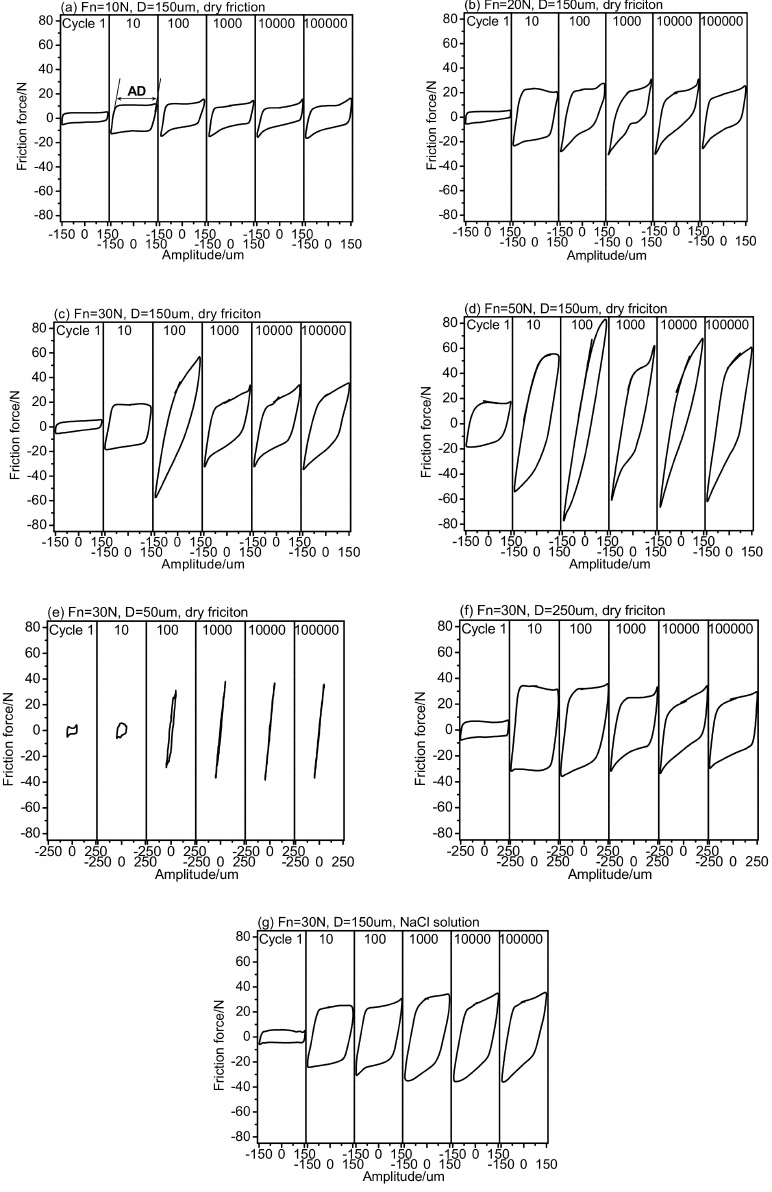
Figure 3. ( a – g ) Fretting running curve of the Al